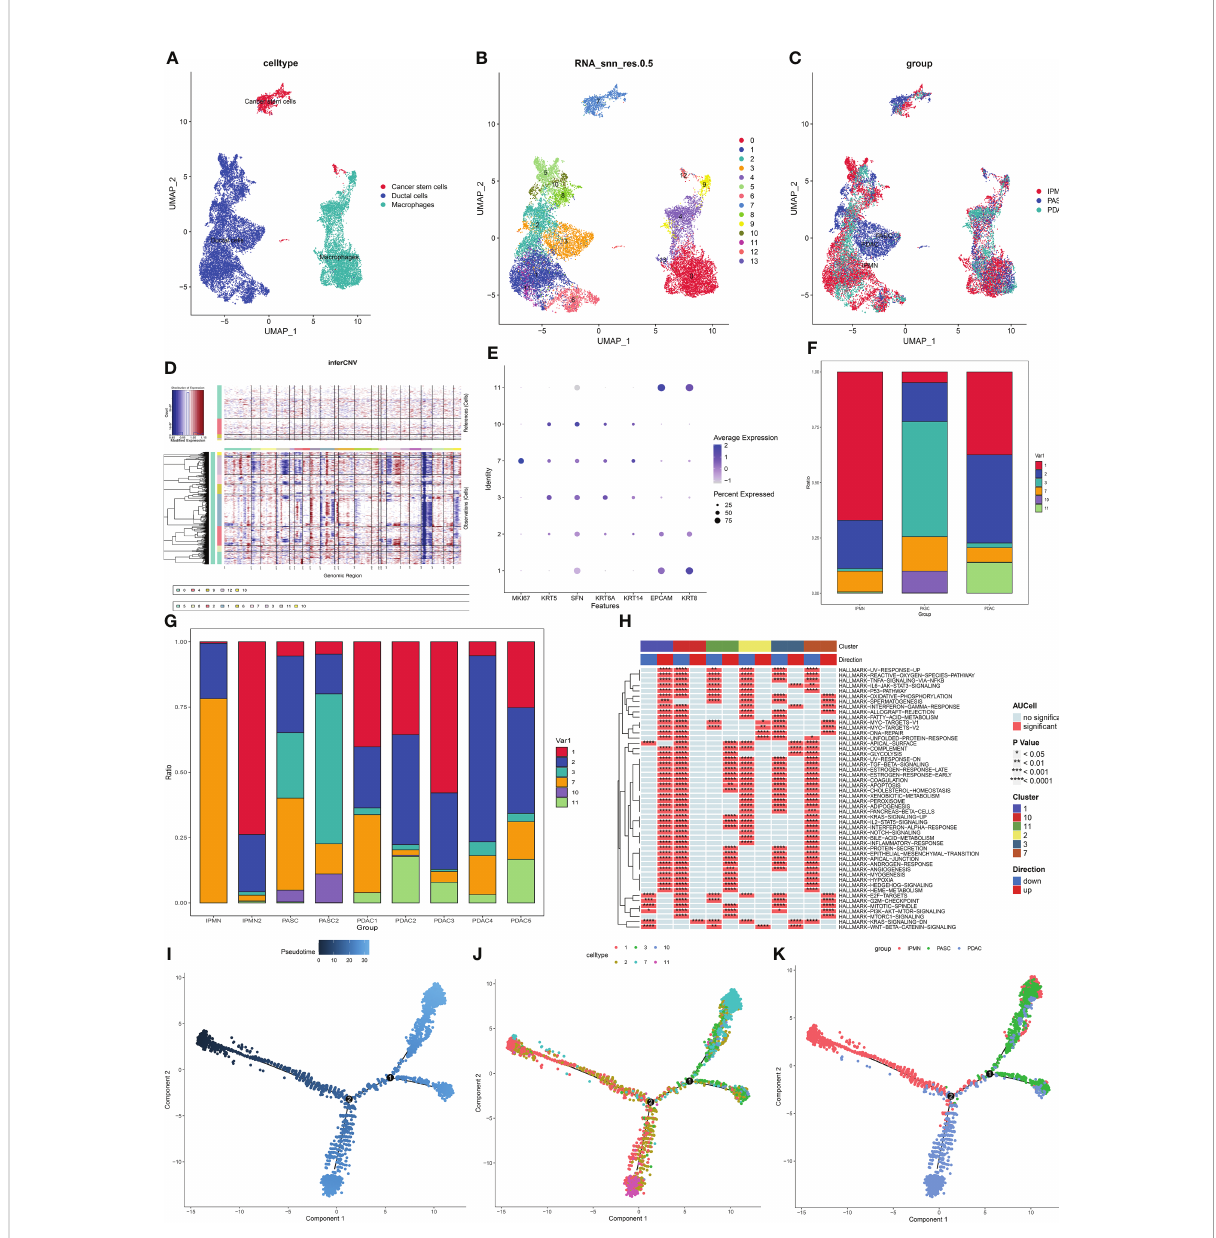
FIGURE 5 (A) UMAP plot of cancer stem cells, ductal cells, and macrophages. (B) UMAP plot of subgroups in cancer stem cells, ductal cells, and macrophages. (C) UMAP plot of cancer stem cells, ductal cells, and macrophages among ASPC, IPMN, and PDAC. (D) Infercnv plot identi fi ed malignant cells in duct cells and cancer stem cells. (E) Expression of squamous and columnar epithelium markers in the subgroups. (F) Bar graph of the proportion of each identi fi ed subgroup in each group. (G,H) Bar graph of the proportion of each identi fi ed subgroup in each sample. (I – K) Pseudotime analysis of these annotated groups in ASPC, IPMN, and PDAC. UMAP, Uniform Manifold Approximation and Projection; ASPC, pancreatic adenosquamous carcinoma; IPMN, intraductal papillary mucinous